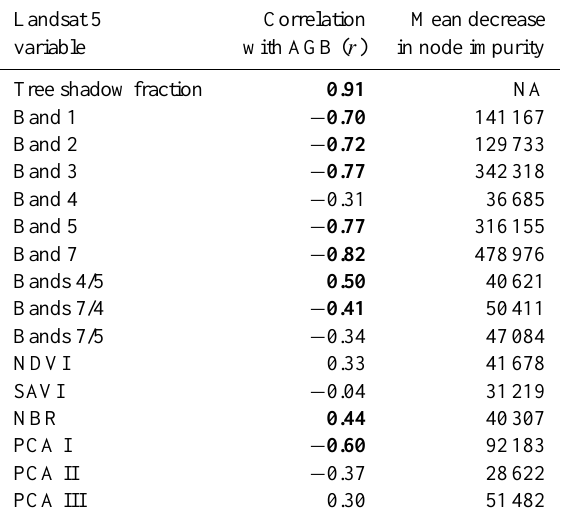
Table 3. Landsat 5 indices used as predictor variables with the Ran- dom Forest algorithm to model tree shadow fraction. Pearson’s cor- relation ( r ) with aboveground biomass and the mean decrease in node purity, a Random Forest generated metric of variable impor- tance, are provided for each predictor variable. Correlations in bold are significant at α < 0.05.